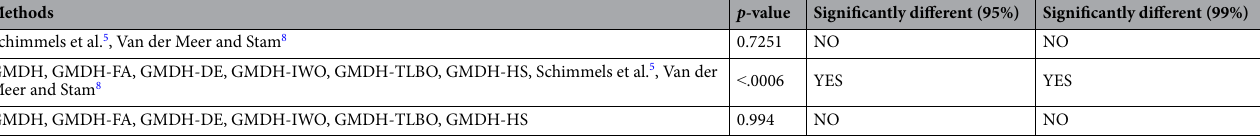
Table 7. The results of the Kruskal–Wallis test for assessing the significant statistical differences between the applied models.